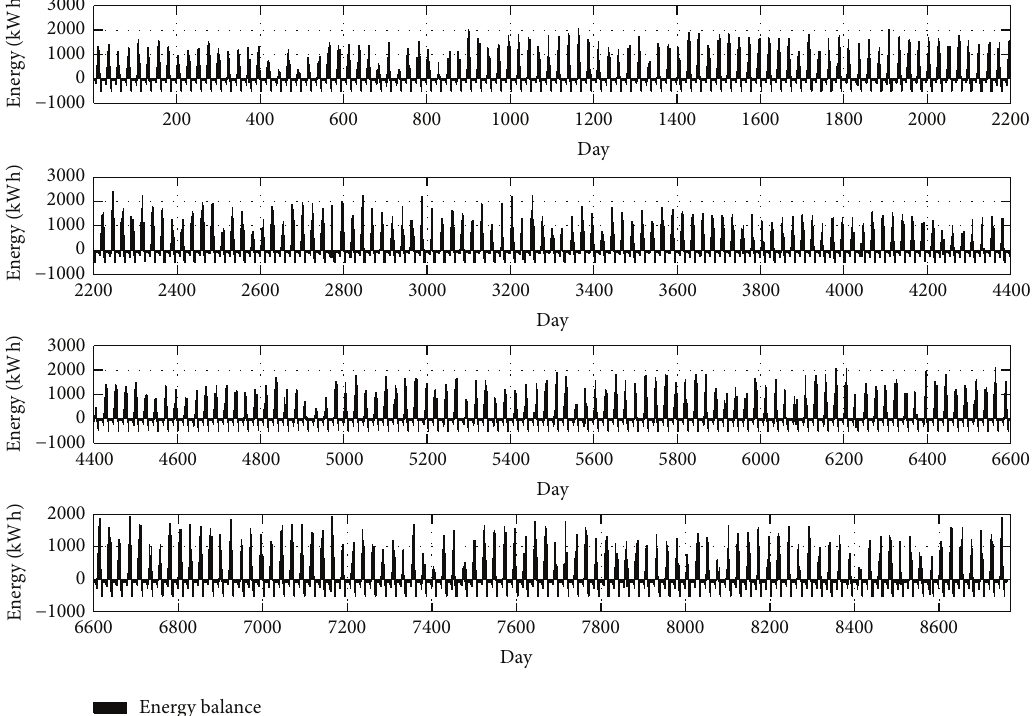
Figure 6: Energy balance for designed PV system.